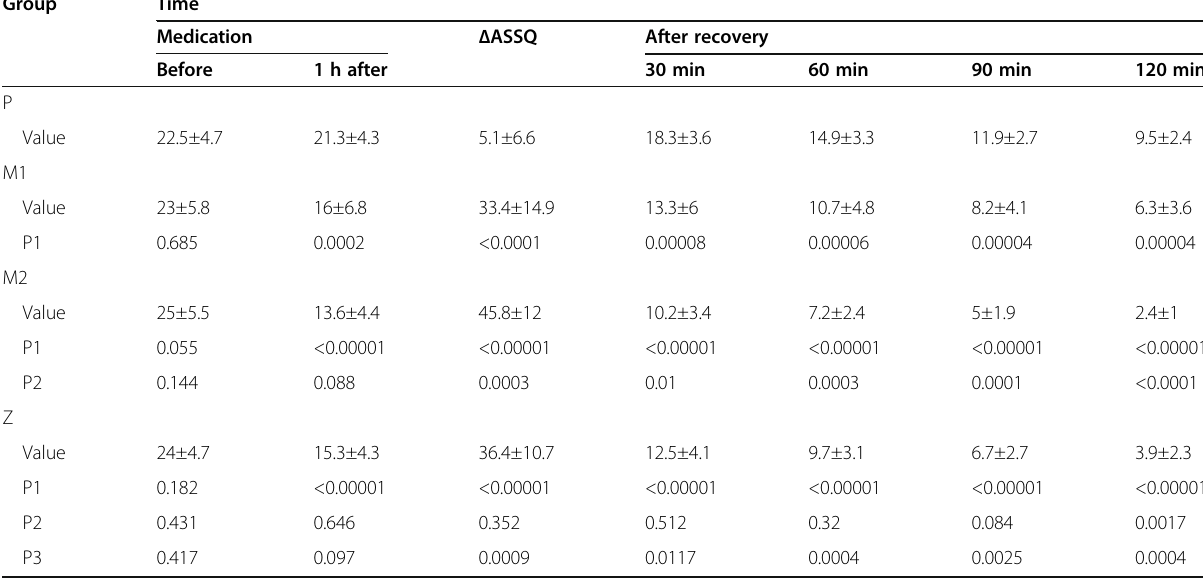
Table 2 ASSQ scorings of patients of the four groups till 120-min after recovery of anesthesia Group Time Medication Δ ASSQ After recovery Before 1 h after 30 min 60 min 90 min 120 min